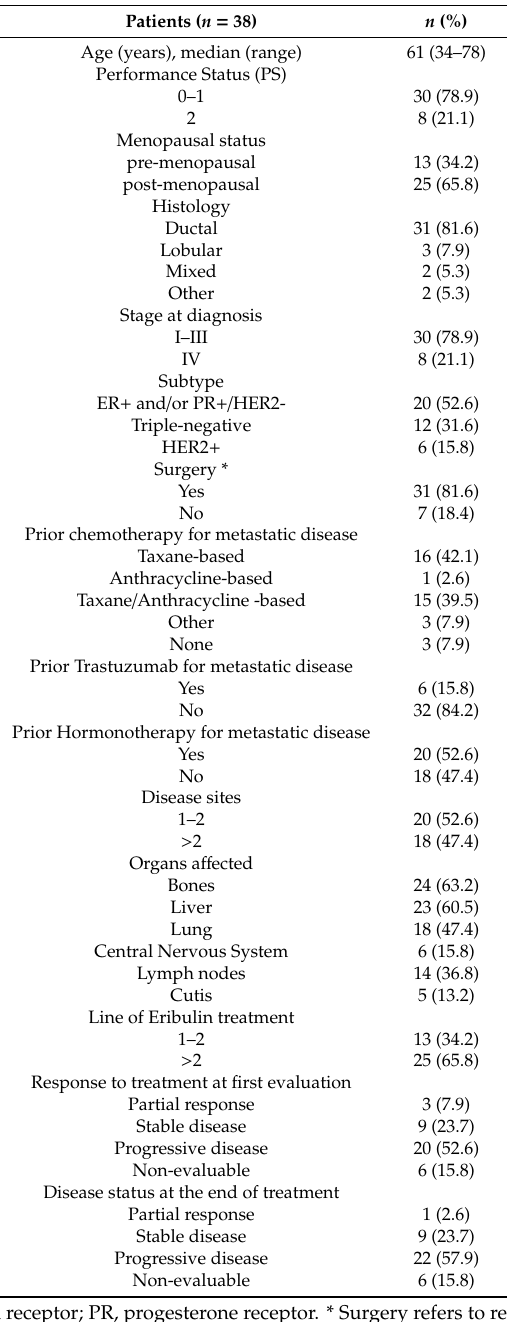
Table 1. Patient and disease